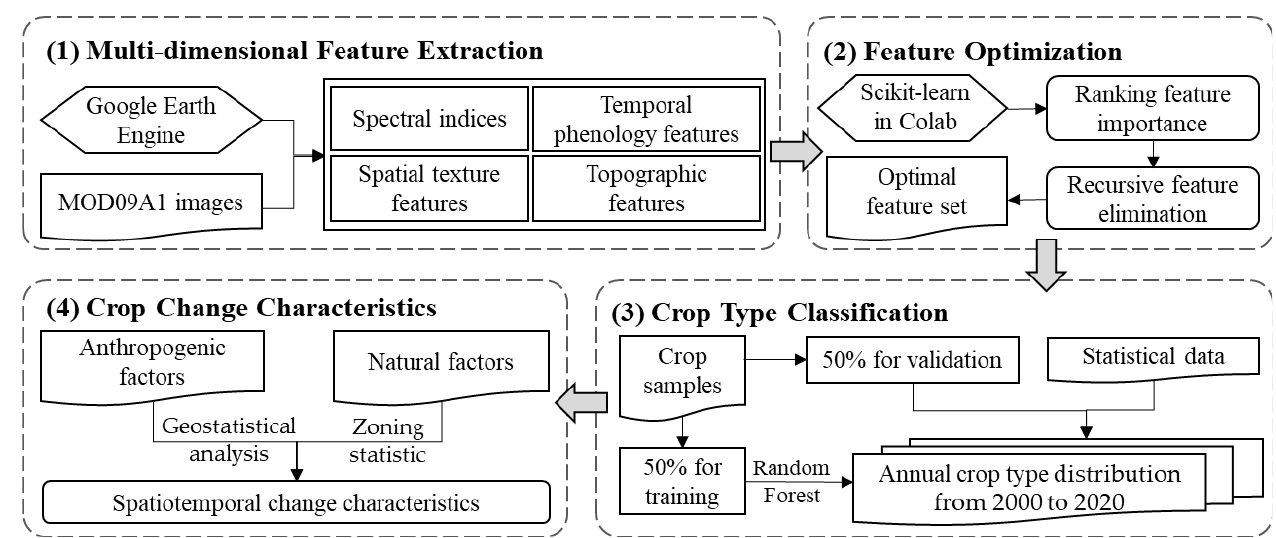
Figure 2. Framework for crop type classification and change characteristics analysis.